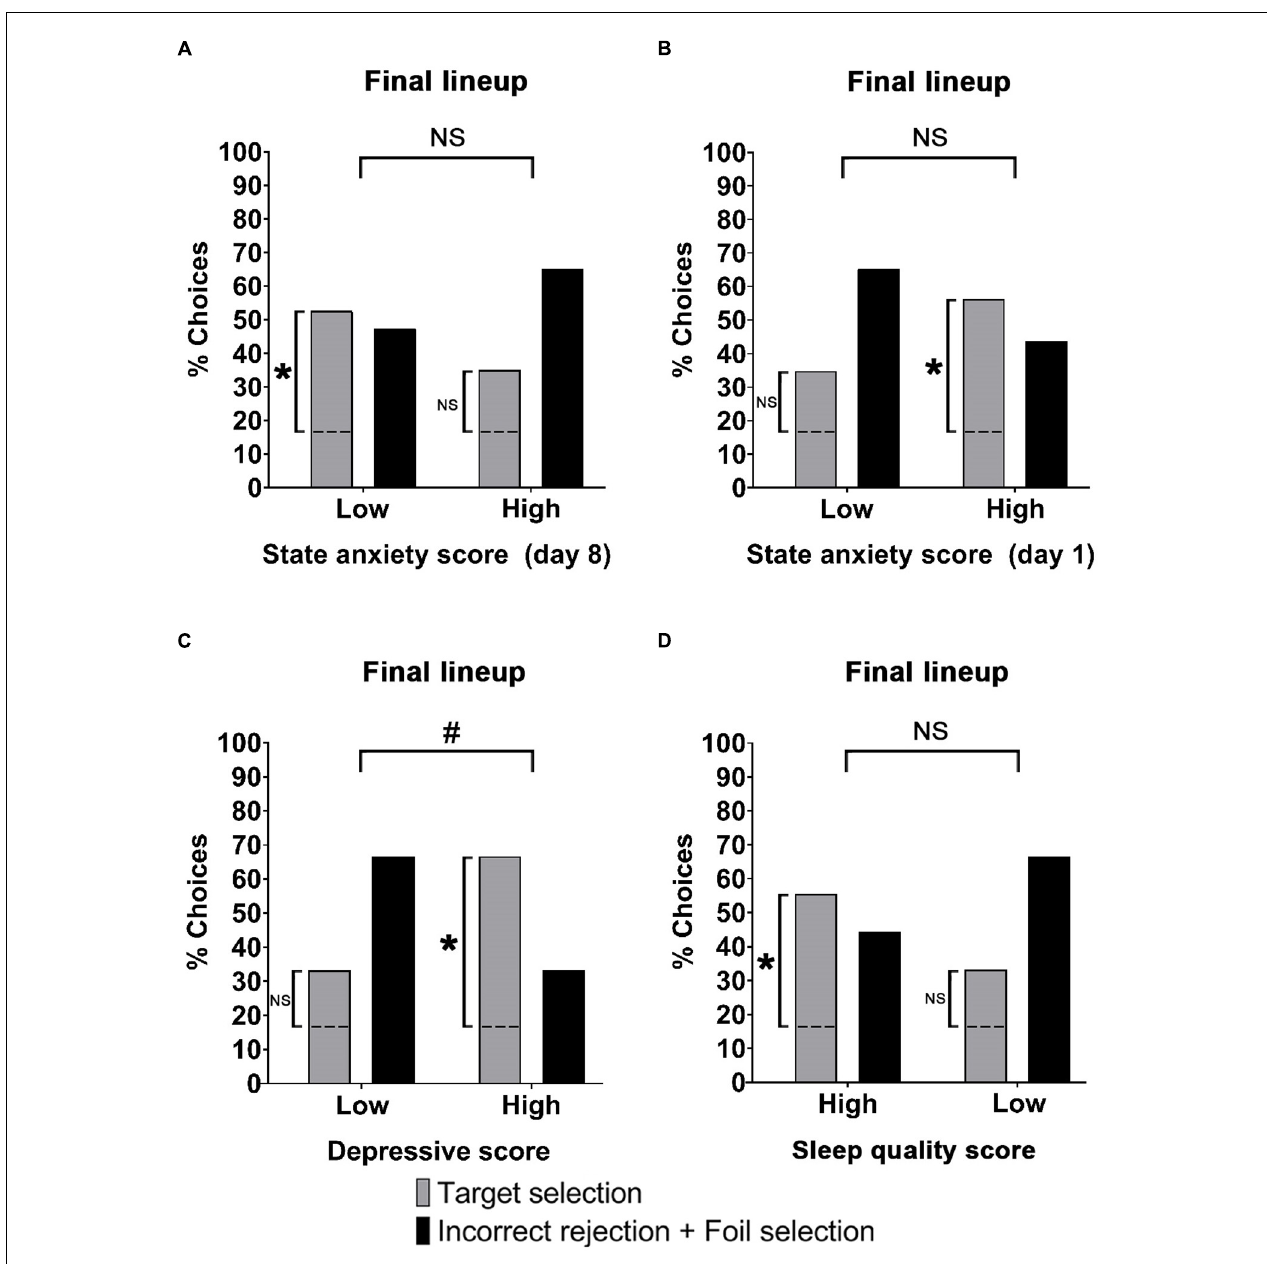
FIGURE 4 | Symptomatology scores and percentage of target selection (correct) and incorrect rejection + foil selection (incorrect) for the With perpetrator group at Final lineup. (A) Percentage of correct and incorrect recognitions for high and low anxiety scores on day 8. Low anxiety: correct ( N = 10) and incorrect ( N = 9). High anxiety: correct ( N = 7), incorrect ( N = 13). (B) Percentage of correct and incorrect recognitions for high and low anxiety scores on day 1. Low anxiety: correct ( N = 9), incorrect ( N = 7). High anxiety: correct ( N = 8), incorrect ( N = 15). (C) Percentage of correct and incorrect recognitions for high and low depression scores. Low depressive: correct ( N = 9), incorrect ( N = 18). High depressive: correct ( N = 8), incorrect (4). (D) Percentage of correct and incorrect recognitions for high and low sleep quality scores. High sleep quality: correct ( N = 10), incorrect ( N = 8). Low sleep quality: correct ( N = 7), incorrect ( N = 14). * p < 0.05; NS, p > 0.05. The dashed lines stand for the chance level (17% of correct responses). The perpetrator was included in the Final Lineup of both